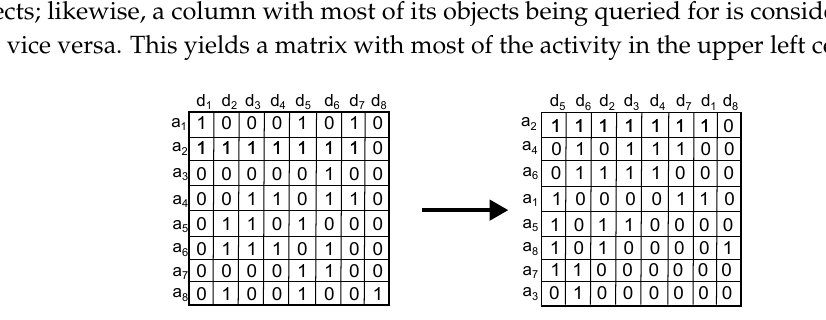
Figure 1. Step 1. Example of applying the sorting method on a Q w matrix. IP addresses are denoted by the symbol a i while objects are denoted by the symbol d j .